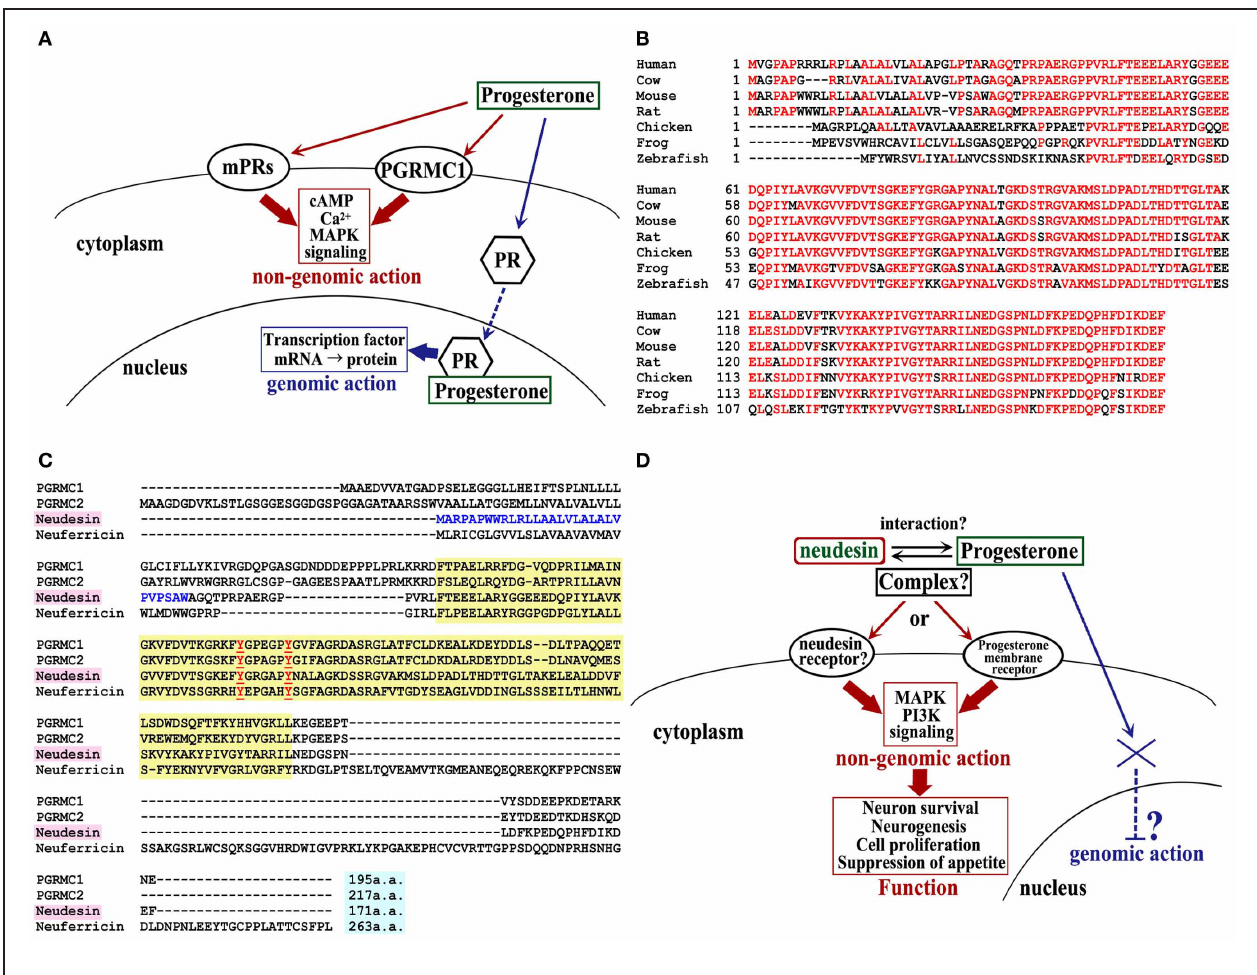
(NM_001030454), and zebrafish (NM_001037704). The consensus sequence is shown in red. (C) The cytochrome b5 heme-binding (Cyt-b5) domain is indicated by the yellow box. Two conserved tyrosine residues, which are important for heme binding, are shown in red. The predicted signal peptides of neudesin are shown in blue. (D) Putative neudesin